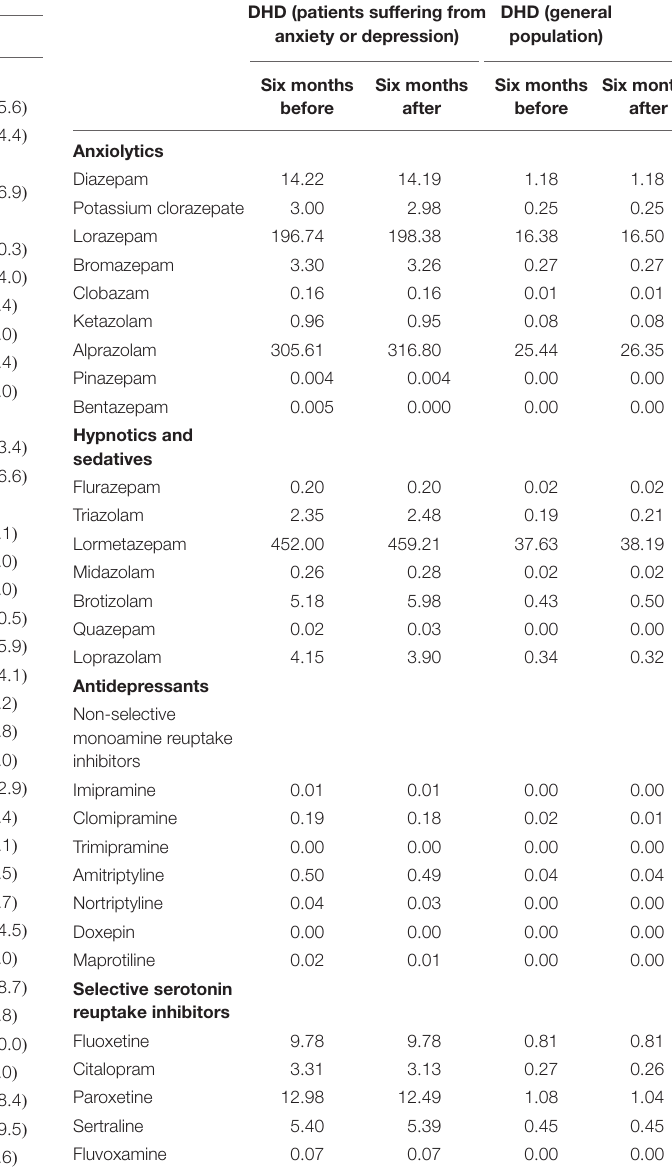
TABLE 1 | Sociodemographic date and chronic comorbidities in patients suffering from anxiety or depression in Aragon.